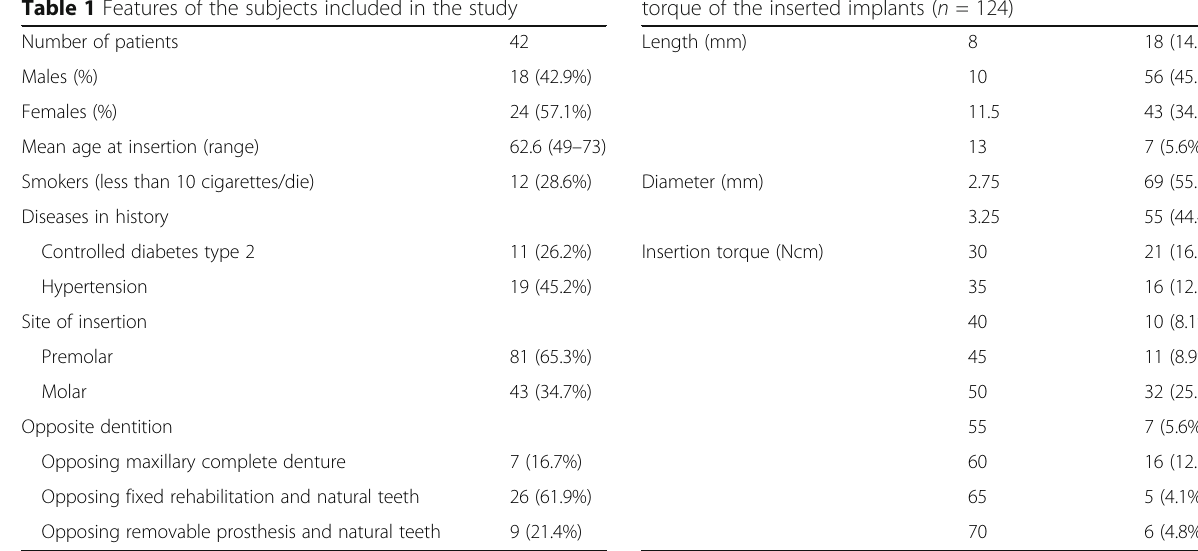
Table 2 Dimensions (diameter and length) and final